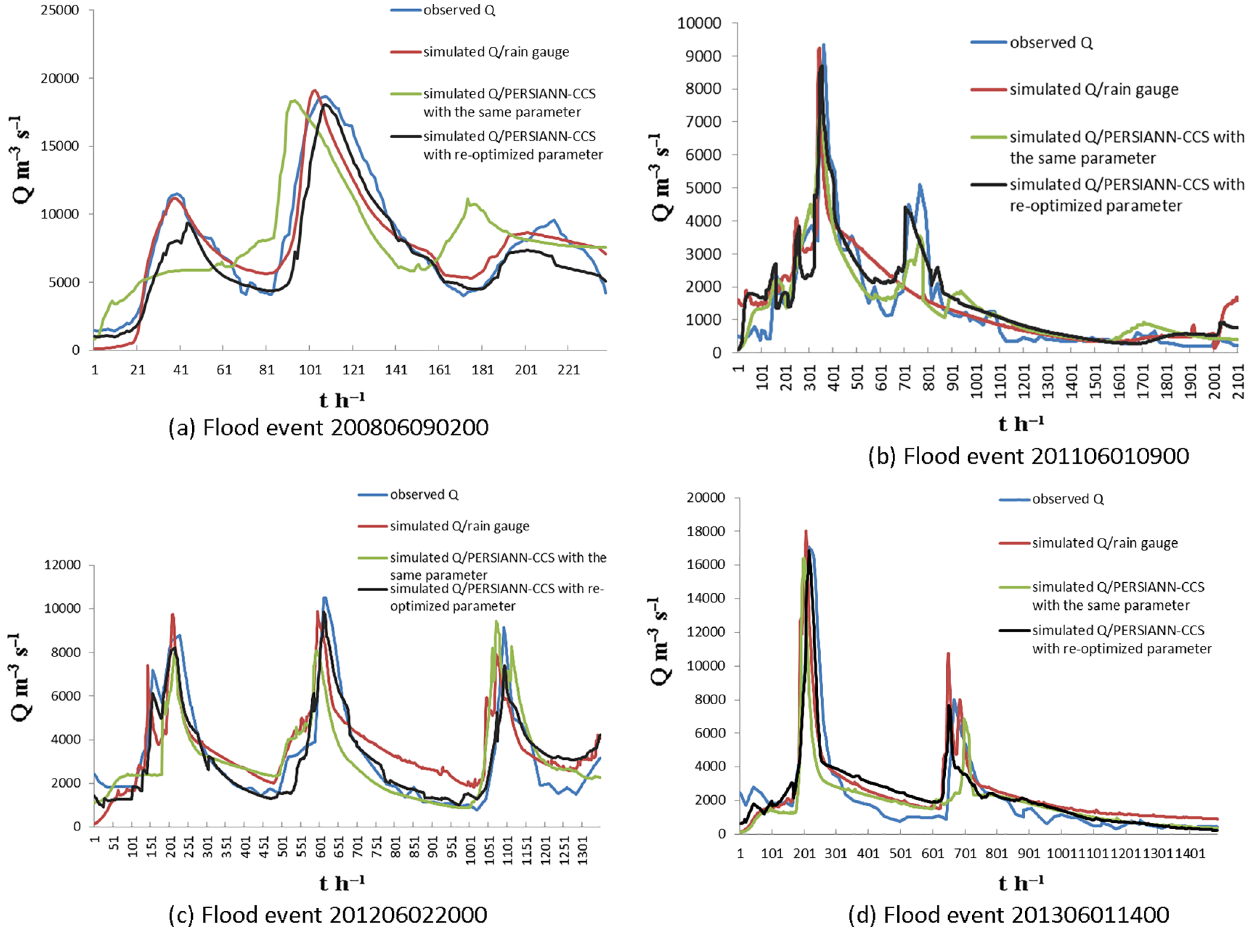
Figure 15. Coupled flood simulation results using the same parameter as the rain gauge precipitation and using the re-optimized param- eter from the post-processed PERSIANN-CCS QPEs. (a) Flood event 200806090200. (b) Flood event 201106010900. (c) Flood event 201206022000. (d) Flood event